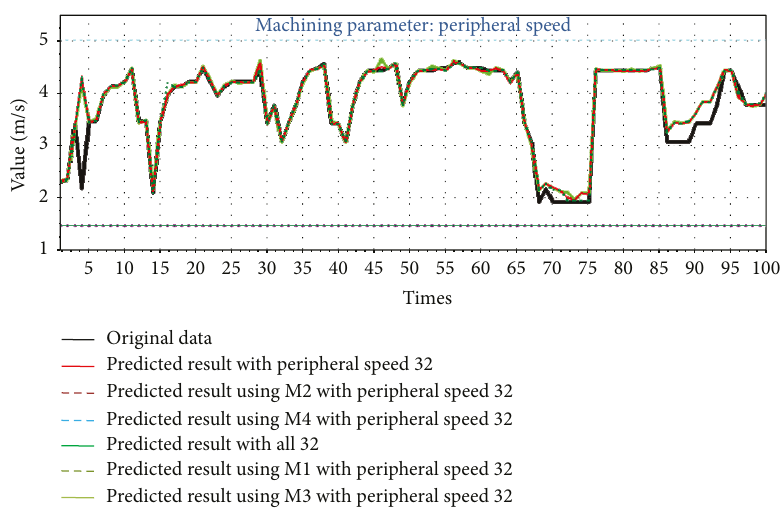
Figure 19: Predicted results of peripheral speed of grinding